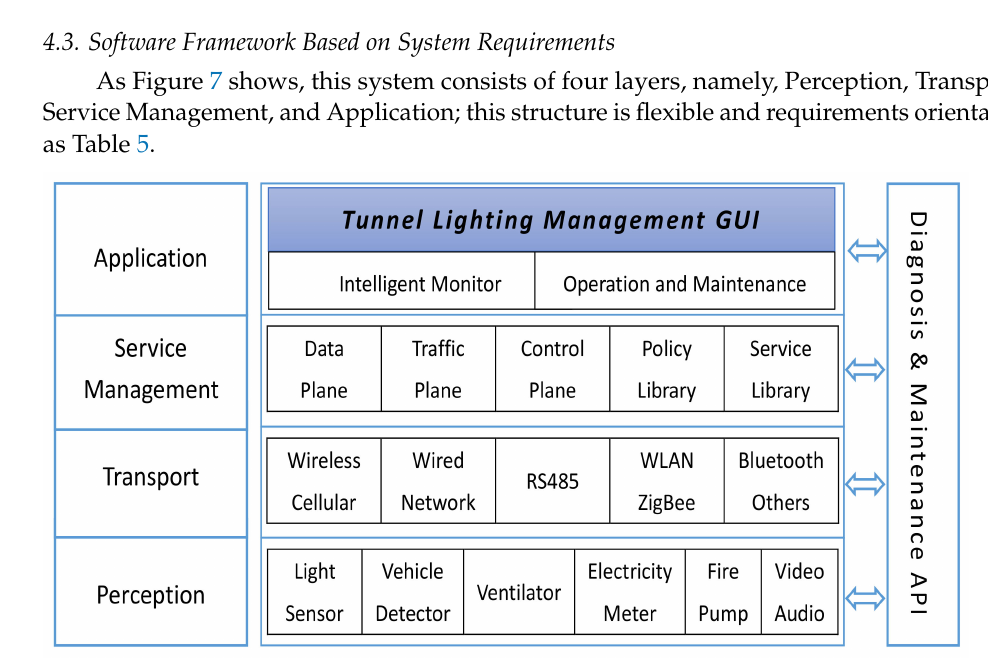
Figure 7. Overall architecture of the tunnel lighting control